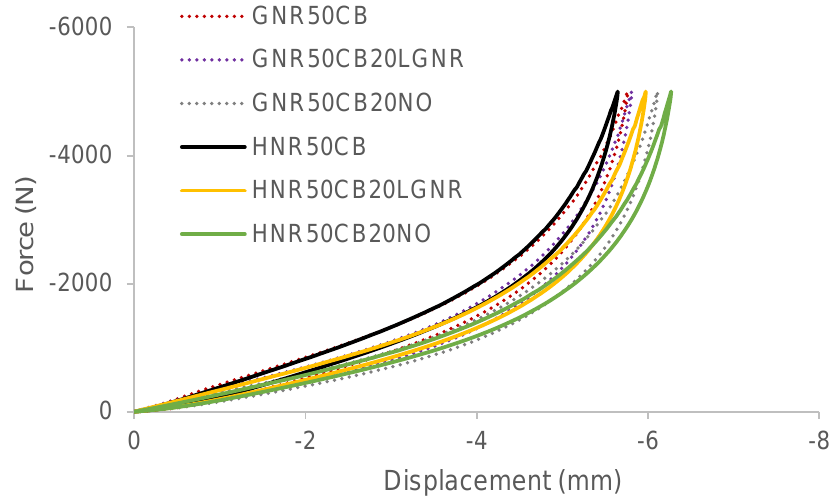
Figure 12. Force–displacement curves of natural rubber composites. The dynamic stiffness (Kd) of GNR, represented by the complex stiffness K* parameter, was reduced by both processing aids at both amplitudes evaluated (Figures 13a and 14a). Nevertheless, GNR composites containing LGNR had higher Kd than with NO. A similar trend was obtained for HNR composites, although the Kd of the HNR composite with LGNR was closer to that of the HNR composites without processing aids. and a good polymer–filler interaction, which increased the effective filler